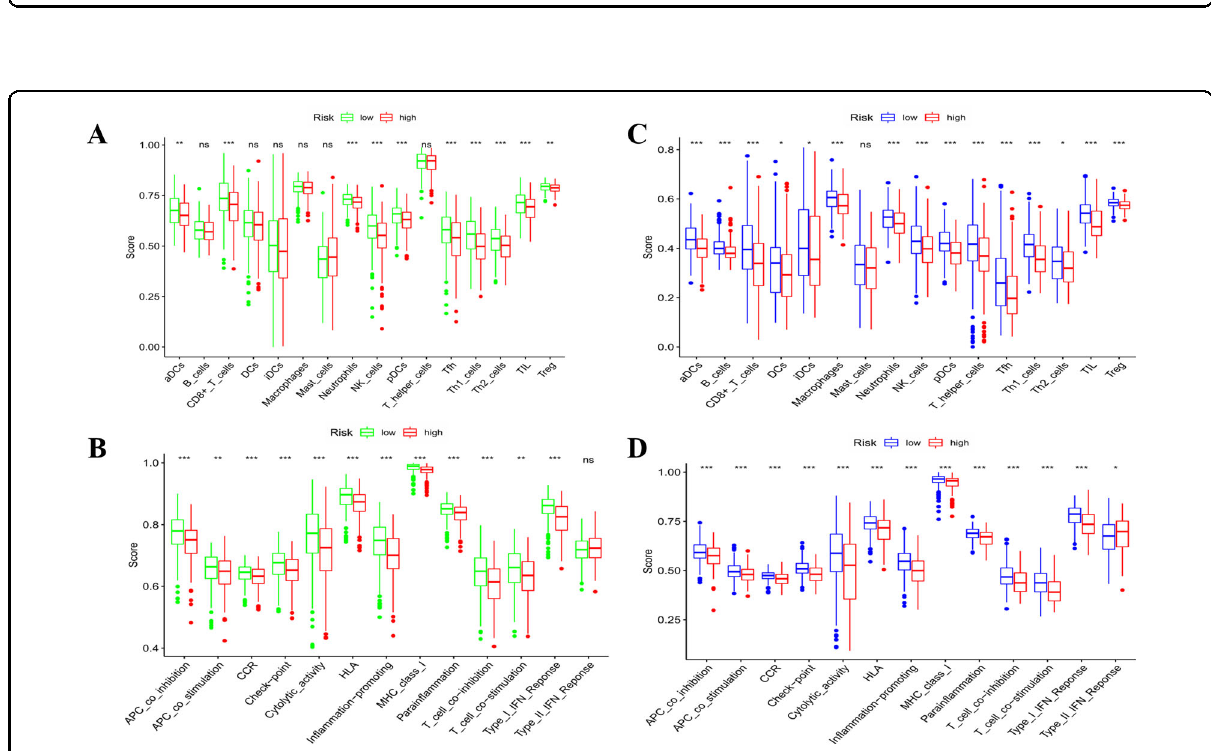
Fig. 6 Functional analysis based on the DEGs between the two-risk groups in the TCGA cohort. A Bubble graph for GO enrichment (the bigger bubble means the more genes enriched, and the increasing depth of red means the differences were more obvious; q-value: the adjusted p -value). B Barplot graph for KEGG pathways (the longer bar means the more genes enriched, and the increasing depth of red means the differences were more obvious).